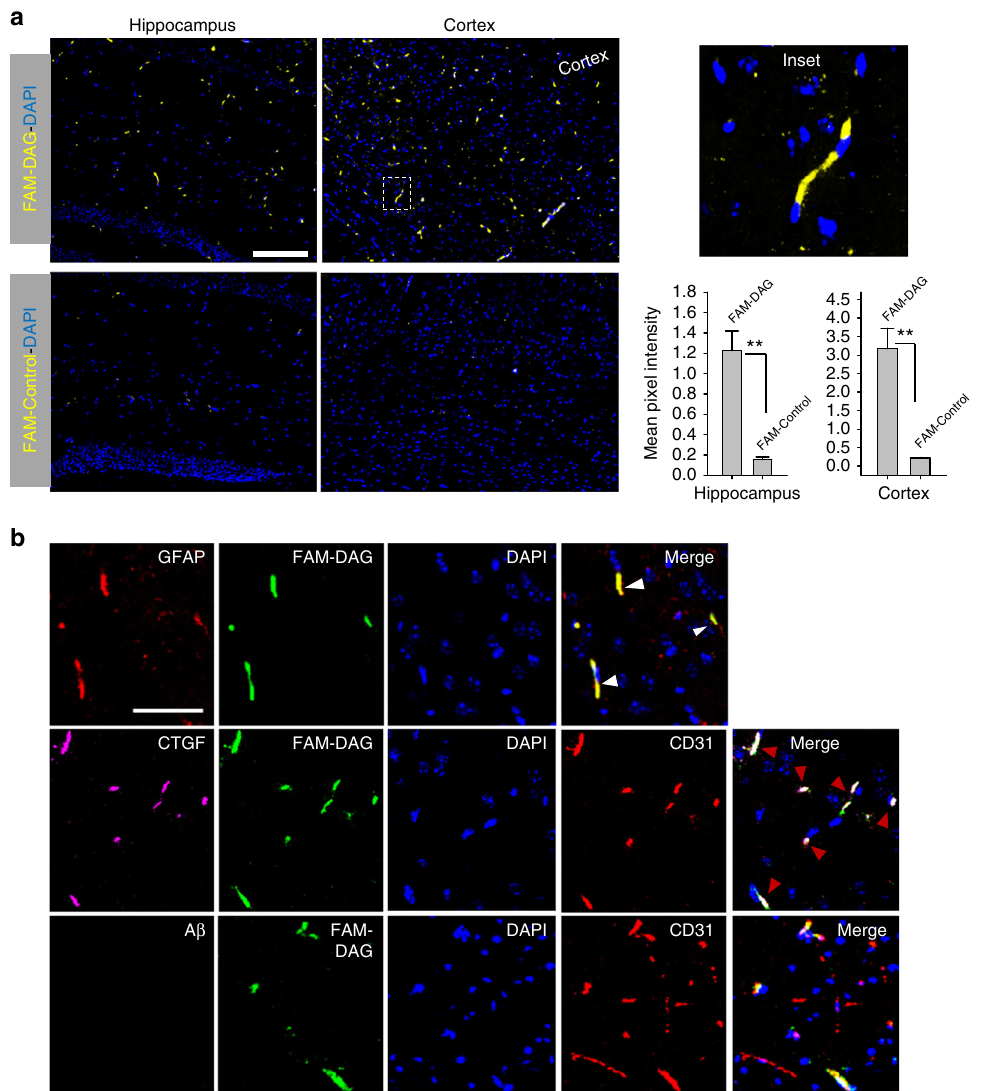
Fig. 4 DAG homing to early stage hAPP-J20 mouse brain. a DAG localizes in the cerebrocortex and hippocampus of young (3 – 4 month old) hAPP-J20 mice after intravenous administration. FAM-DAG or control peptide were intravenously injected and allowed to circulate for 30 min. The mice were perfused, and brains were fi xed, sectioned and stained for FAM ( green ). The signal from FAM was quanti fi ed using ImageJ and plotted in bar graph. The region shown is the cortex. b DAG co-localizes with CTGF and blood vessels in the hAPP-J20 mice. Sections from panel a were stained for FAM ( green ), CTGF ( magenta ), GFAP ( red in fi rst row), and CD31 ( red in second and third row). The region shown is the cortex. Arrowheads point at DAG (FAM)-CTGF-CD31 co-localization. The blood vessels lack detectable A β accumulation ( bottom row ). Scale bar , 50 µ m. ** P <